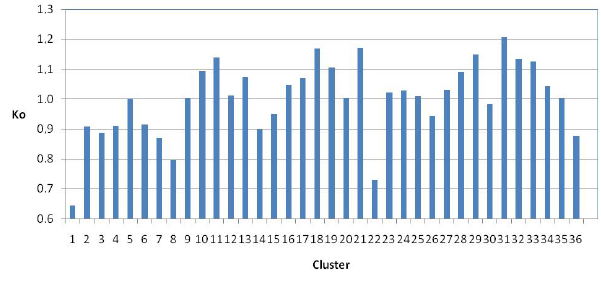
Fig. 10. The Ko index for the 36-cluster